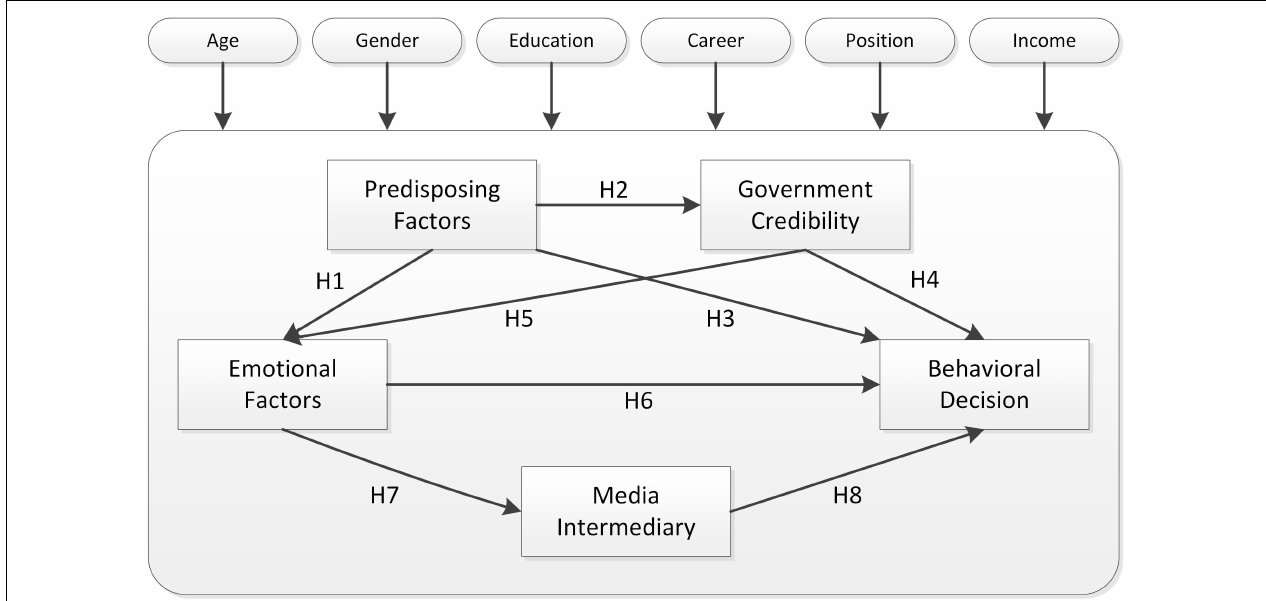
FIGURE 1 | Multi-factor theoretical model of sentiment and behavior in public